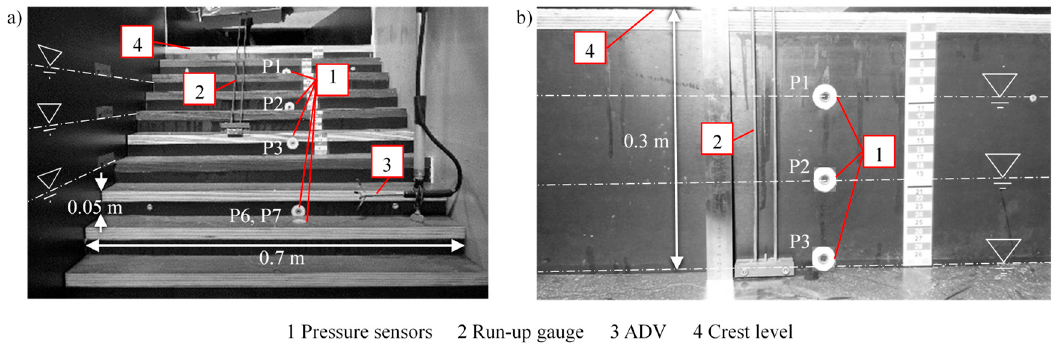
Figure 2. Model set-up with instrumentation for ( a ) step height 0.05 m and ( b ) step height 0.3 m.